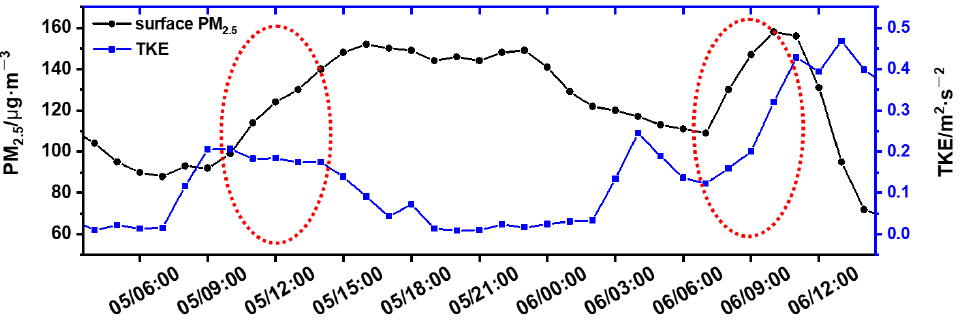
Figure 9. Variations of the turbulence intensity by eddy correlation systems and surface PM 2 . 5 concentration at Xianning station from 04:00 LST on 5 January to 12:00 LST on 6 January. The red circle indicates the rapid increase period of the surface PM 2 . 5 concentration on 5 and 6 January.